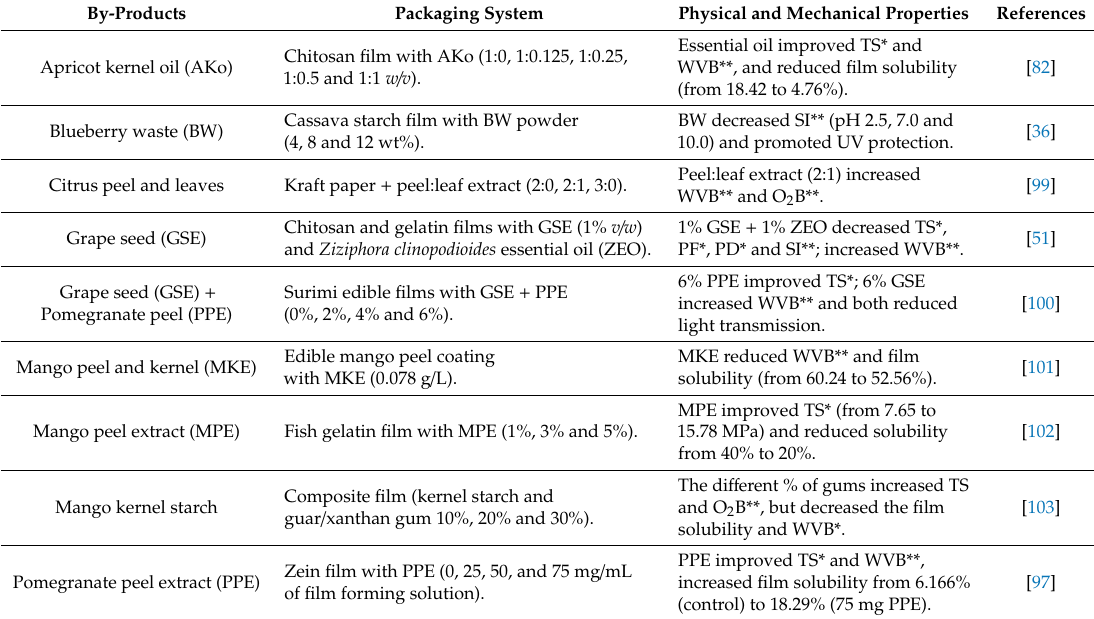
Table 3. Fruit by-products and their e ff ects on physical and mechanical